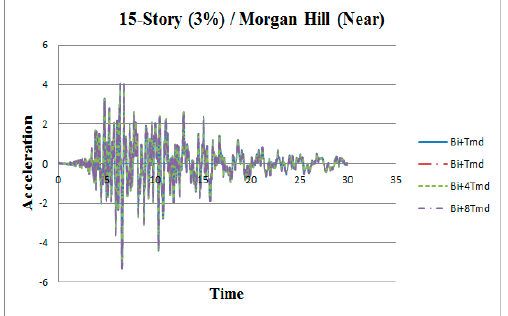
Figure A5. Acceleration time histories for top story of 15-story building under the Loma Prieta (near-fault) earthquake.